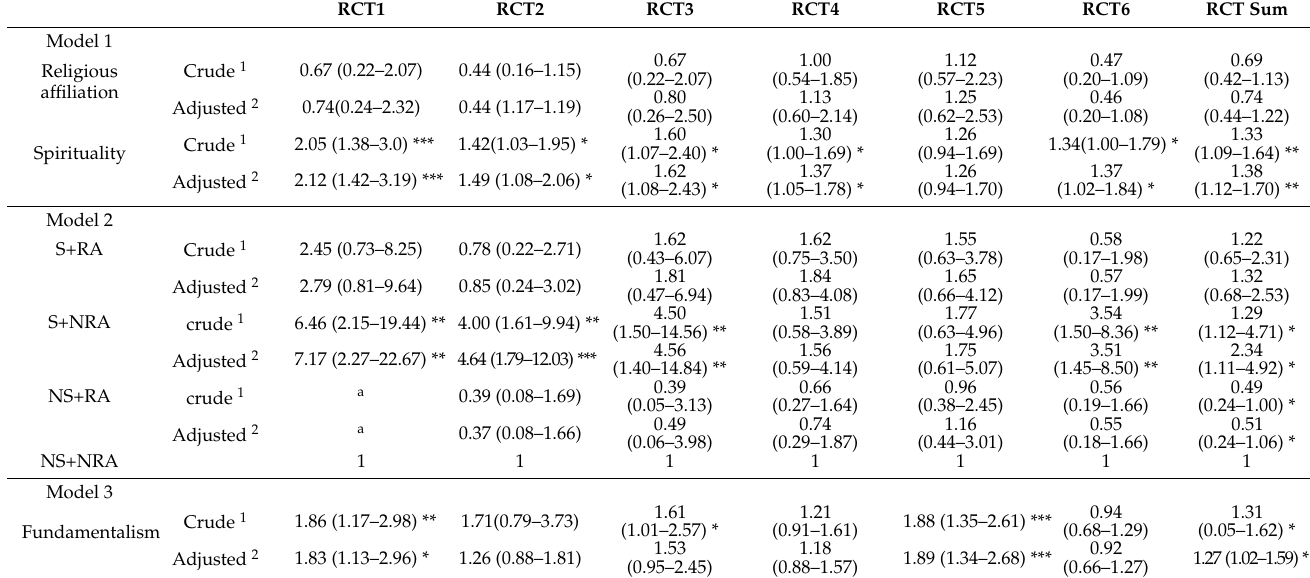
Table 2. Associations of religious affiliation, spirituality (standardised to Z-scores), different combinations of religious affiliation and spirituality, and religious fundamentalism (standardised to Z-scores) with RCT beliefs: Results of binary logistic regression (crude and adjusted) for age, gender, and education level leading to odds ratios (OR) with 95% confidence